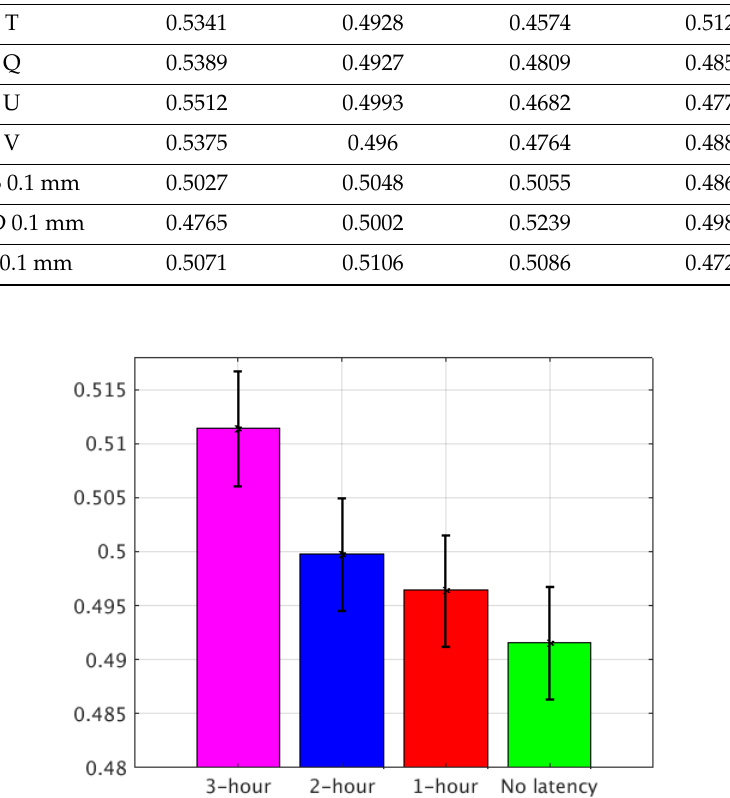
Figure 8. The final normalized RMSE of the four experiments with the 95% confidence intervals for Case I.